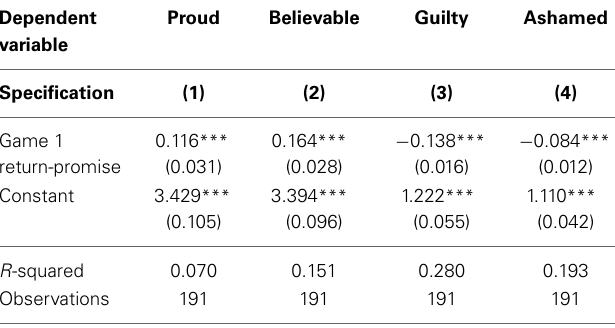
Table 1 | Regression of trustees’ emotions on signal value